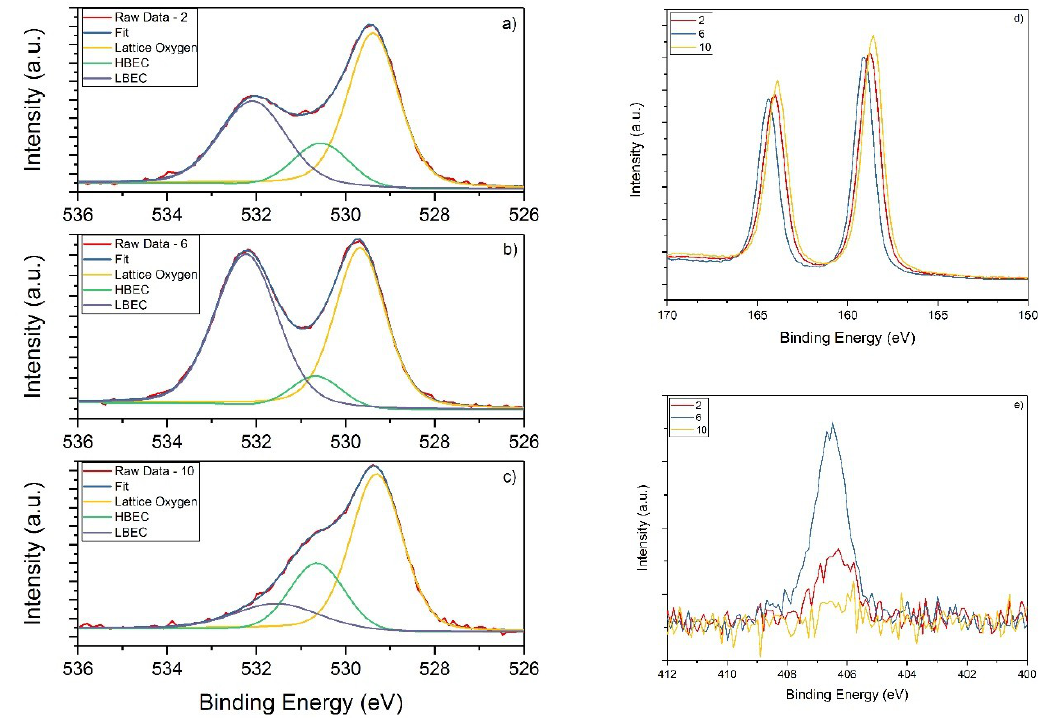
Figure 3. Detailed XPS spectra of ( a – c ) oxygen, ( d ) bismuth, and ( e ) nitrogen.